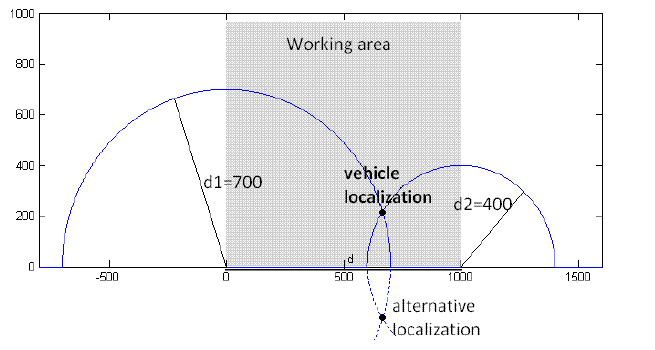
Figure 6. Localization schema, the distance between the two fixed points is known, and the prototype coordinates can be calculated using d1, and d2